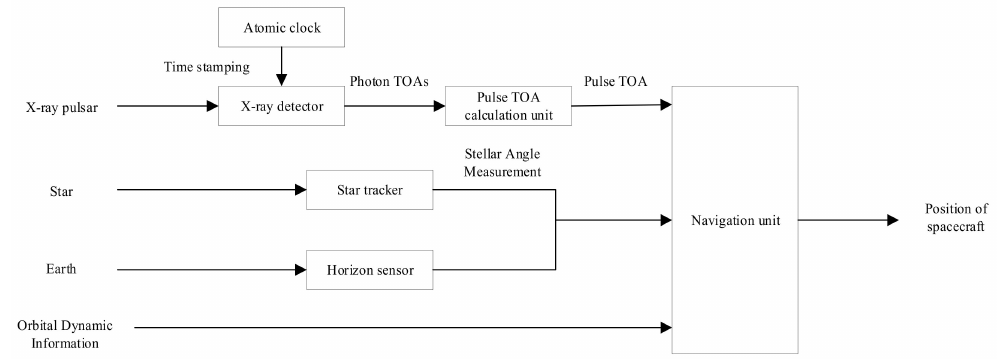
Figure 2. Composition of the current integrated navigation system using the X-ray pulsar and stellar angle.